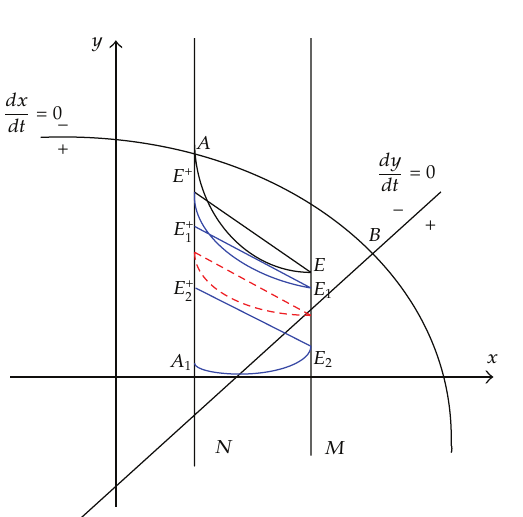
Figure 3: Illustration of system (cid:6) 1.3 (cid:7) for the case h < x ∗ , y E (cid:9) < y A .